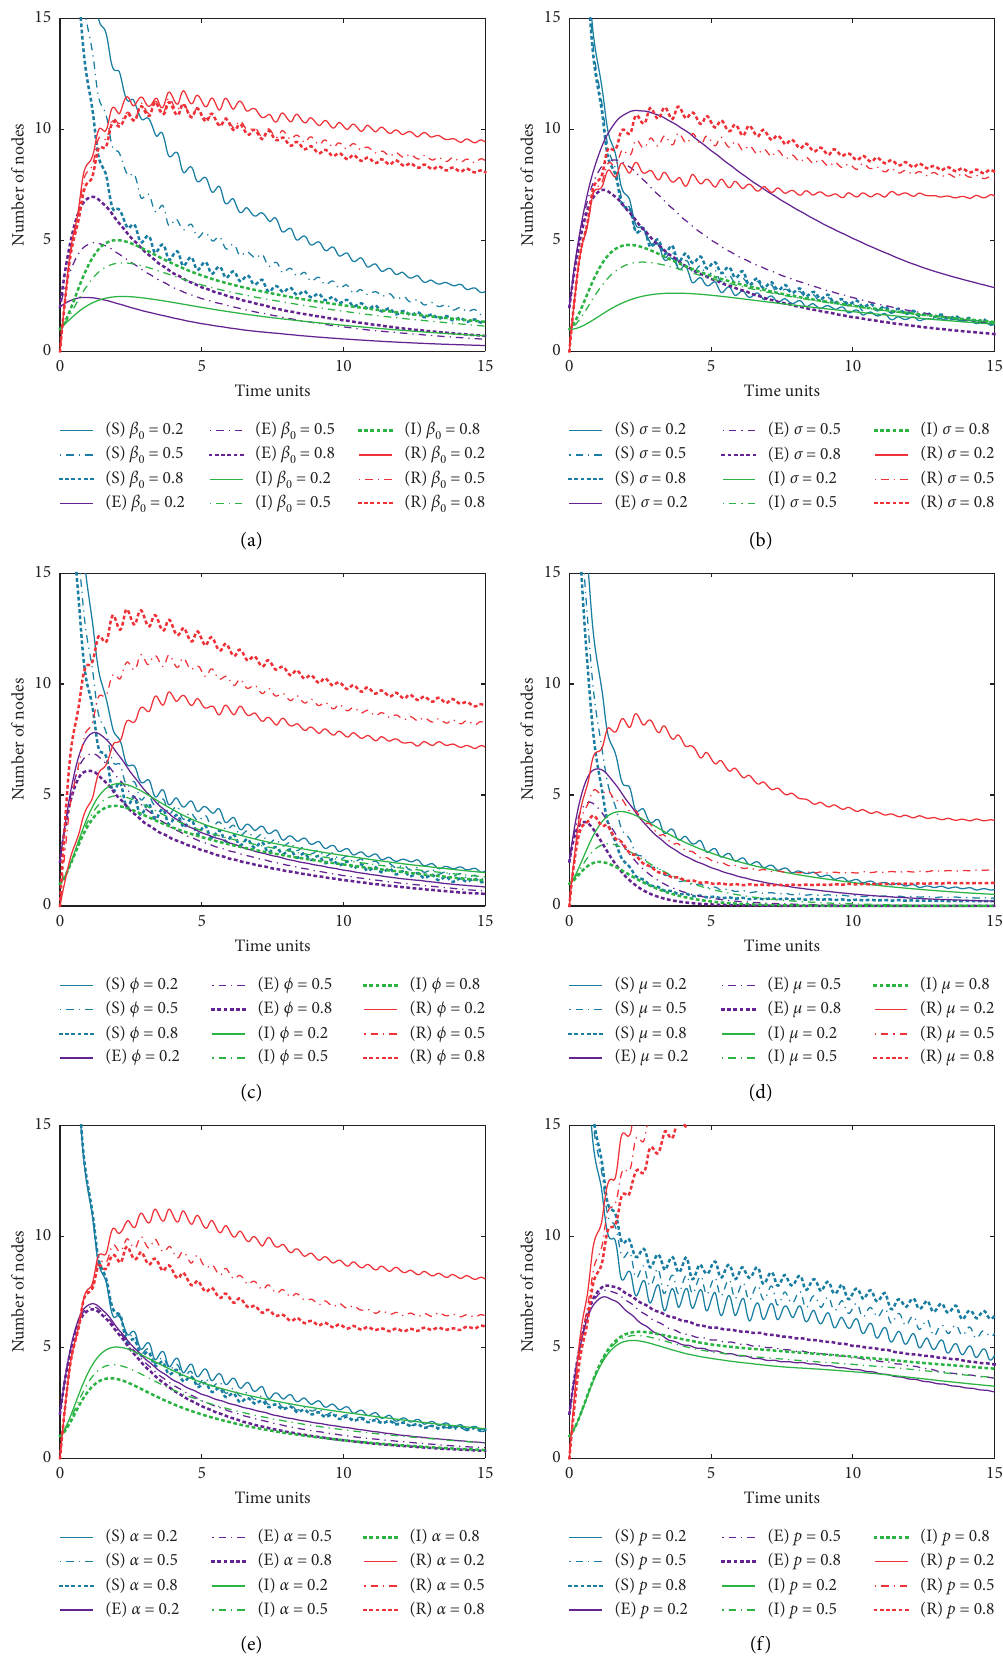
Figure 4: Simulation of the MalSEIRS model varying at different constants and rates. (a) Variation of the constant β rate β t . (b) Variation of the malware execution rate σ . (c) Variation of the rate of immunization ϕ . (d) Variation of the machine unavailability rate provoked by other causes μ . (e) Variation of the machine unavailability rate provoked by malware α . (f) Variation of the birth’s susceptibility rate p when the number of new nodes Λ �